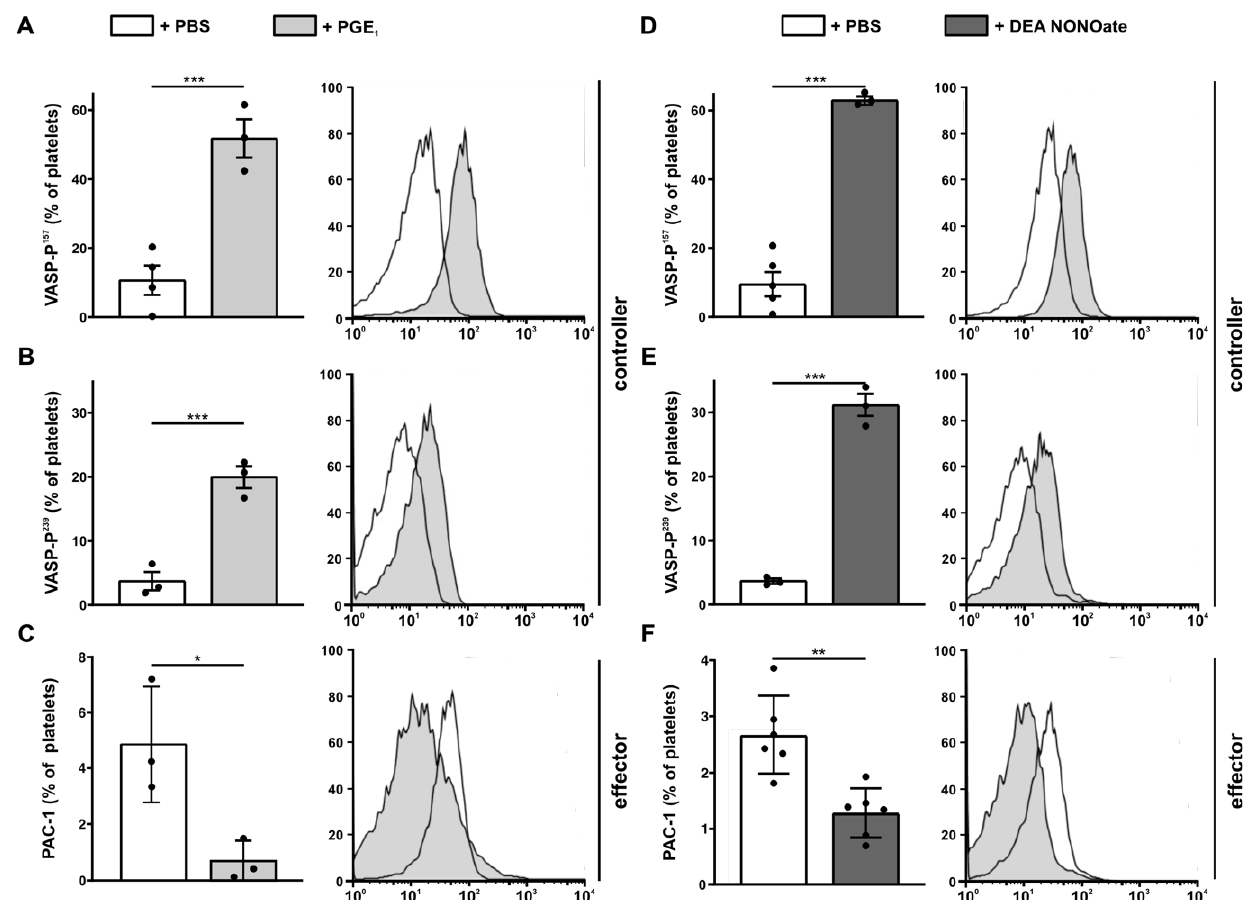
Figure 4. Analysis of the set points. Human platelets were treated with ( A – C ) either PGE 1 (the more stable variant of PGI 2 ) or ( D – F ) the NO donor DEA NONOate. Phosphorylation status at position (A+D) Ser 157 and (B+E) Ser 239 is depicted as percentage of platelets with respect to isotype controls (isotype controls and gating strategies are shown in Figure A2). (C+F) Activation status of GPIIb/IIIa was measured by PAC-1 binding and is presented as percentage of positively stained platelets with respect to isotype control (isotype controls, gating strategies, and MFIs are shown in Figures A2 and A4). ( A – F ) One representative histogram is shown for each condition in the right panels (black outlined histogram: untreated, grey filled histogram: treated). n ≥ 3; unpaired Student’s t -test with * for p < 0.05; ** for p < 0.01; *** for p < 0.001.